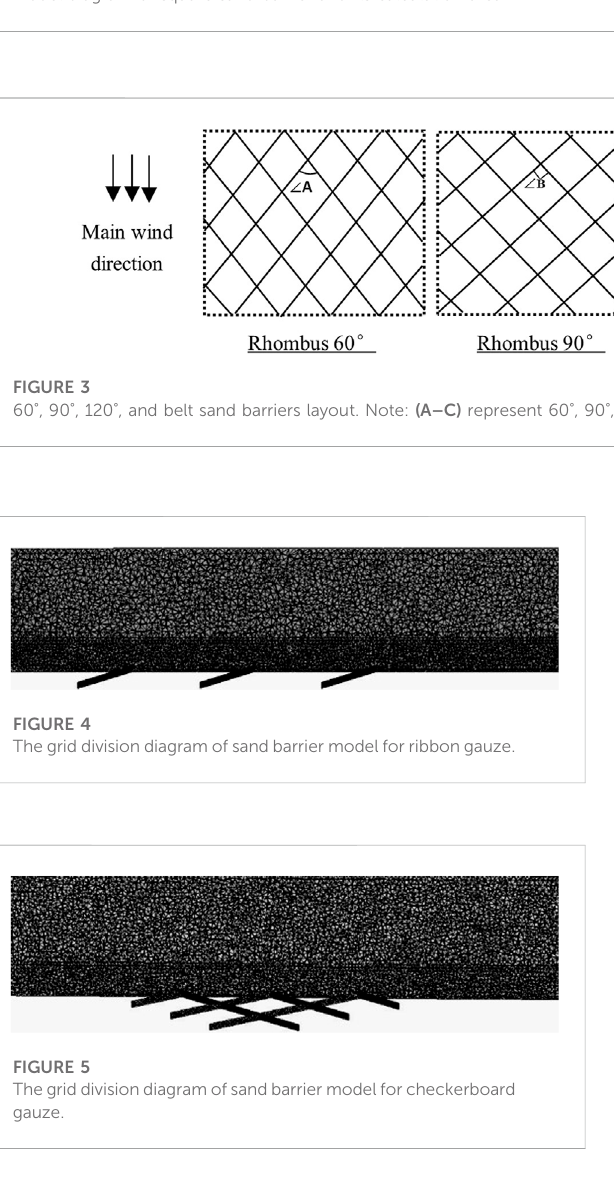
parallel linear (belt) gauze sand barrier are simulated. The schematic diagram of four kinds of gauze sand barrier laying is shown in Figure 3.